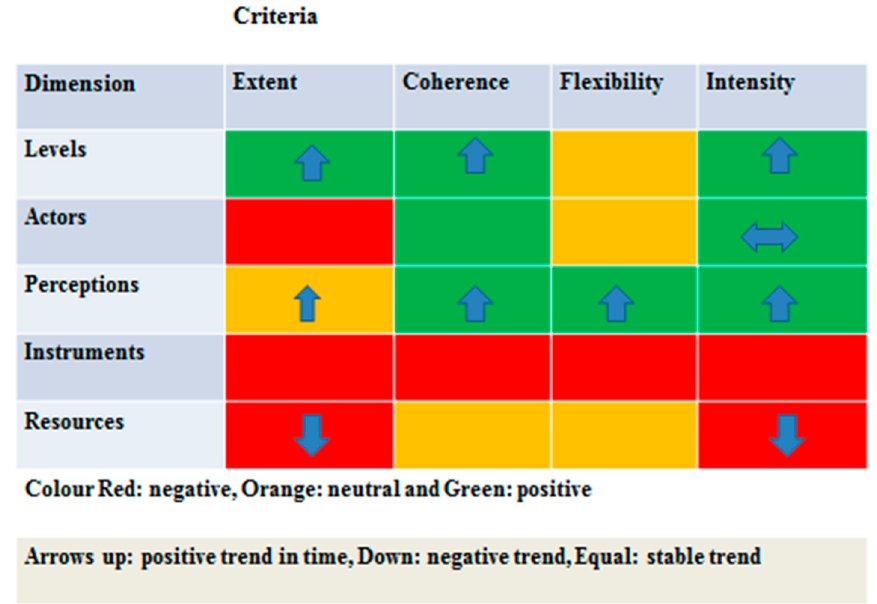
Figure 15. Visualization of governance content of the energy efficiency policy of the major household appliances in Nigeria using the GAT scoring card visualization matrix.